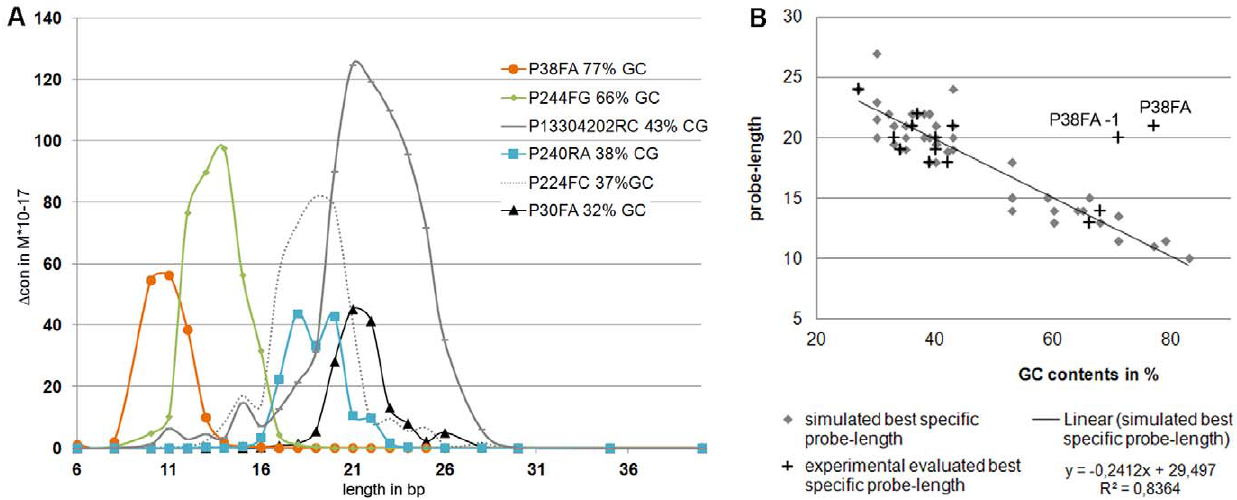
Figure 5. Influence of the G/C contents on D con and HSE success. (A) Comparison of D con from six core probes with different G/C content. For all probe sets, G/C content has been calculated as a mean value for all simulated probe lengths. (B) Diagram showing the linear dependence of probe length and G/C content for optimum specific probes after simulation and HSE extraction. Data points are based on Table 2. Diamonds represent the length and G/C content of probes with the highest simulated D con (n=48), crosses indicate length and G/C content of the probe with the best HSE success (n=11, grey boxes in Table 2A).